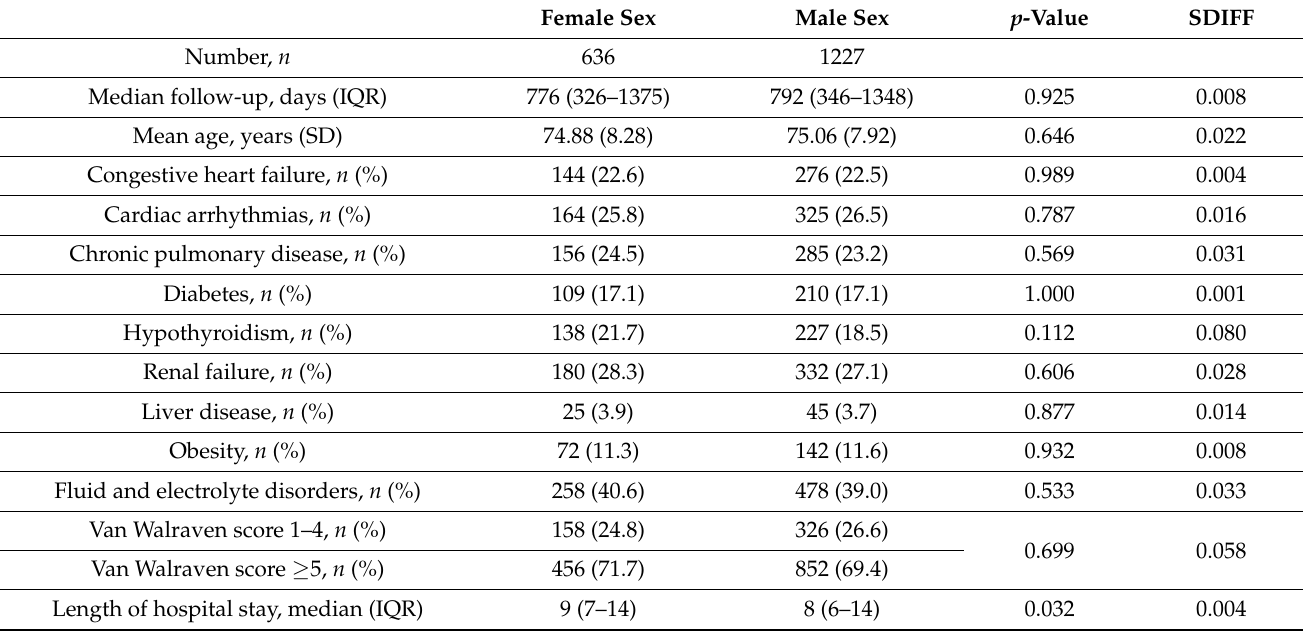
Table 1. Baseline characteristics of the propensity score matched cohort in this retrospective observational study of health insurance